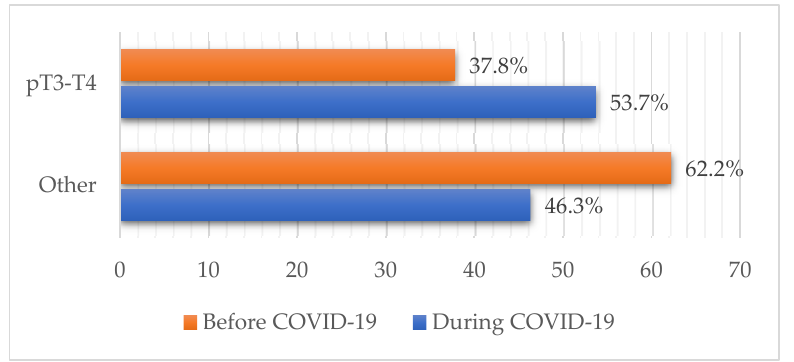
Figure 3. Combined pT staging of melanoma patients before and during the pandemic. An increase in melanomas thicker than 2 mm, viewed through the increase in pT3-4 staged cases was observed (37.8% vs. 53.7%; p = 0.026).